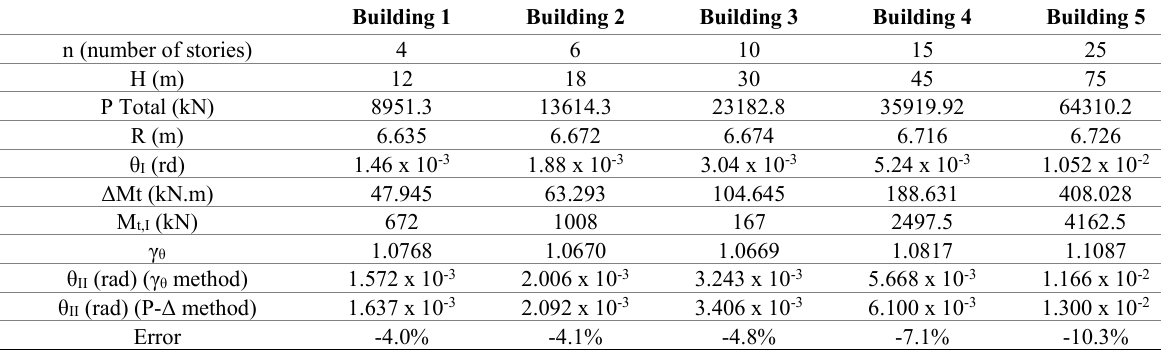
Table 2. γ θ coefficient calculation and comparison with P- Δ method (first